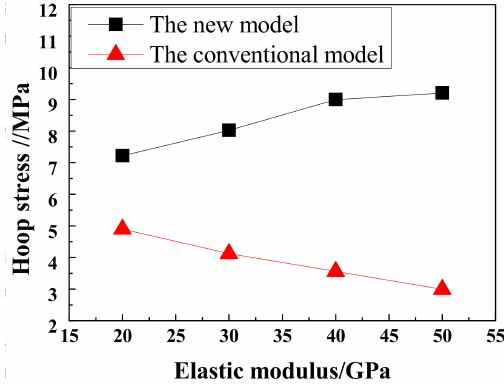
Figure 12. Hoop stress of cement sheath vs. rock elastic